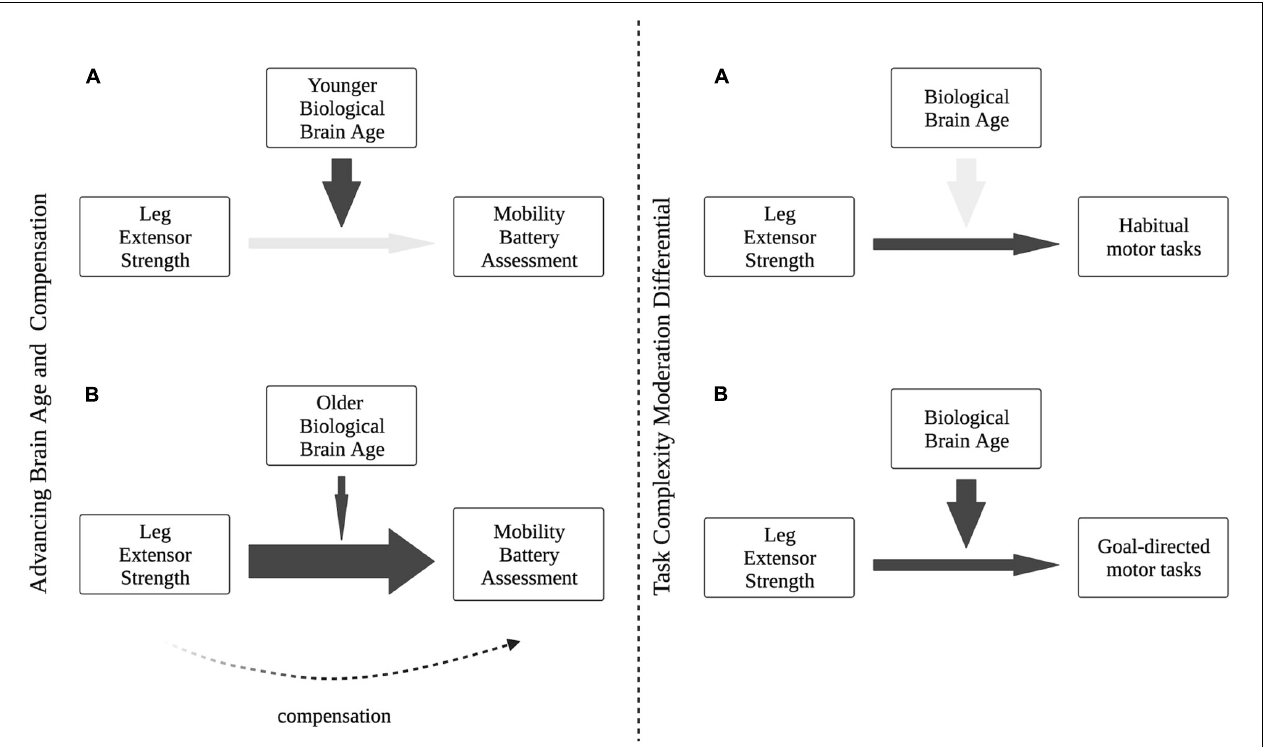
FIGURE 5 | Conceptual framework of our proposed Motoric Aging and Compensation Hypothesis (MACH). (Left panel A) In the context of relatively “younger” brains and adequate neural mechanisms of mobility, strength is not needed as a functional compensation. (Left panel B) With accelerated brain age and decline in neural integrity, strength becomes a stronger predictor of functional performance and maintains functional capacity. (Right panel A) Brain age difference does not moderate the predictive relationship between strength and habitual motor tasks (e.g., gait), indicating neural processing may not be as integral during simpler, more automatic mobility tasks. (Right panel B) Increased task complexity of goal-directed motor tasks necessitates greater neural contribution to functional performance, with brain age moderating the relationship between strength and